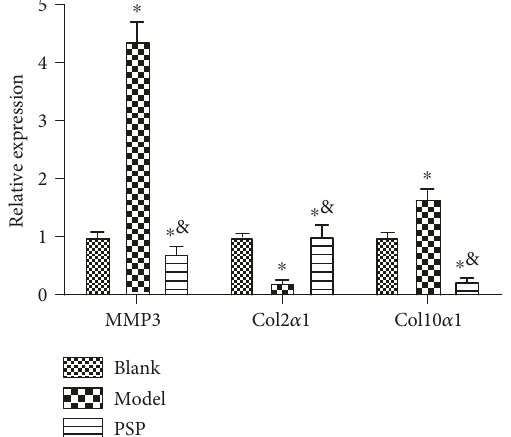
Figure 6: E ff ect of PSP on the expression of Col2 α 1, Col10 α 1, and MMP3 in rats with degeneration of the intervertebral disc. ∗ P < 0 05 , compared with the blank group. & P < 0 05 , compared with the model group.